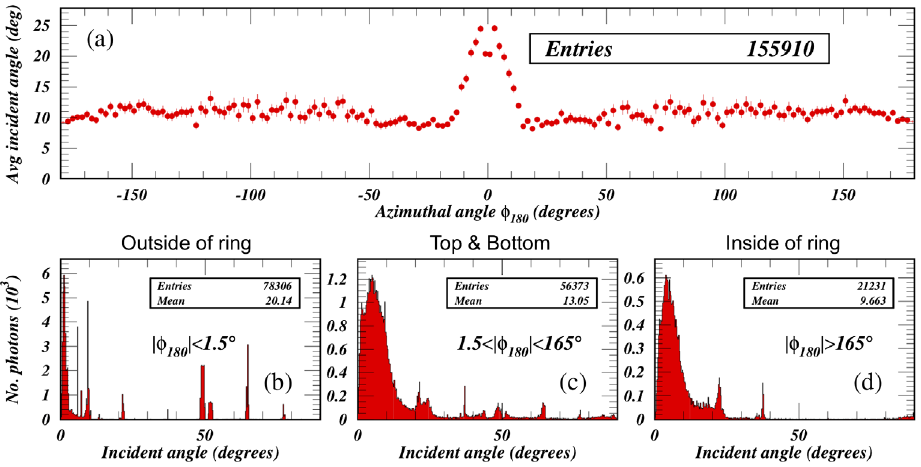
FIG. 12. Average angle of incidence (grazing angle) h θ inc γ i of the absorbed photons summed over the field-free regions of the CESR ring (a) as a function of the azimuthal location on the vacuum chamber wall, Φ 180 . The distributions in three azimuthal regions are shown